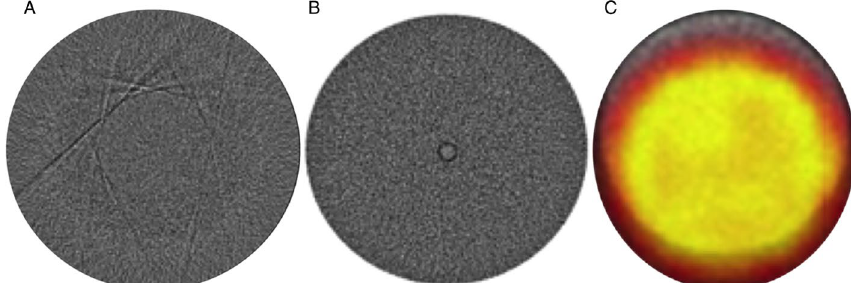
Fig. 7 Images displaying common examples of artefacts that would be seen by visual QC inspection of CT images. Panel A displays an example of CT streaking artefacts. The cause of such streaking artefacts is most of the times due to mechanical failure or imperfections (poor detector sampling and failure). Panel B shows an example of a CT ring artefact mostly caused by a CT centre of rotation error. Panel C is the axial view of a PET/CT phantom showing the misalignment between the PET (colour) and the CT (light grey arc). This is due to scanner hardware being misaligned. McDougald W. PET/CT. In: Imaging Modalities for Biological and Preclinical Research: A Compendium, Volume 2. IOP Publishing; 2021:III.2.a-1-III.2.a-12. https:// doi. org/